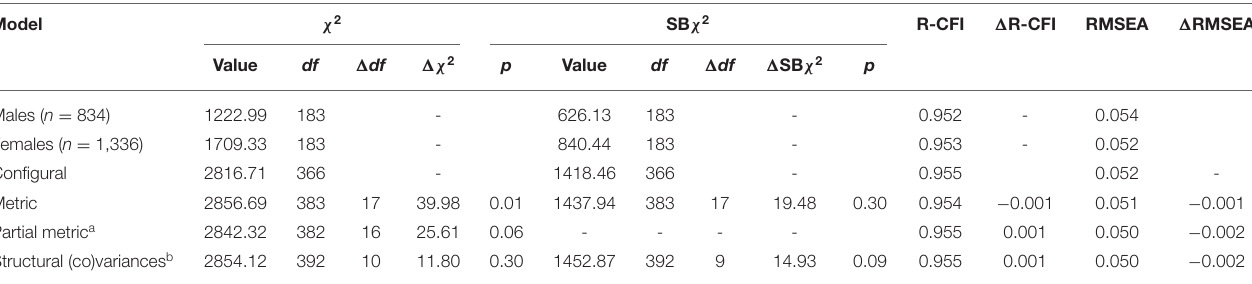
TABLE 5 | Results of the invariance analysis and measurement of the Goal Orientation Scales according to gender.